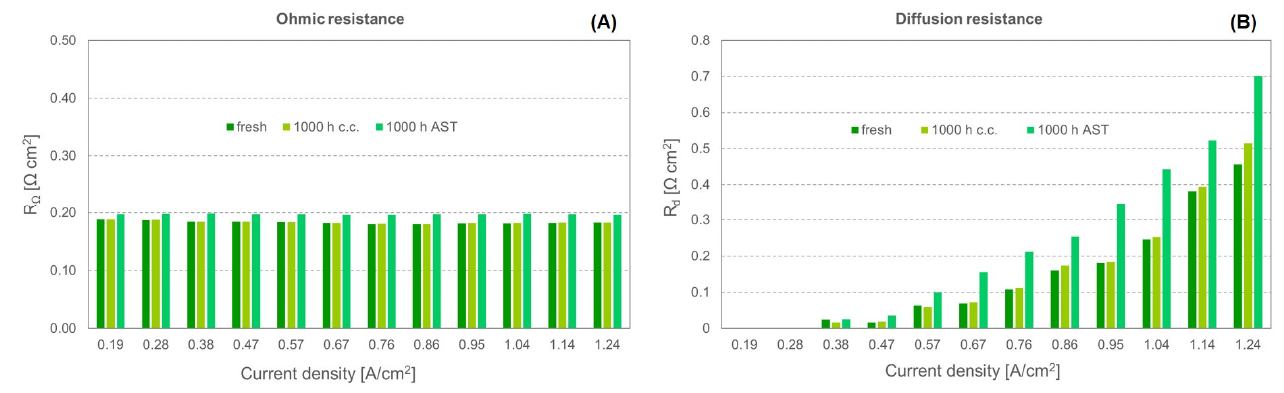
Figure 8. Ohmic ( A ) and mass transfer resistances ( B ) as a function of the current density upon